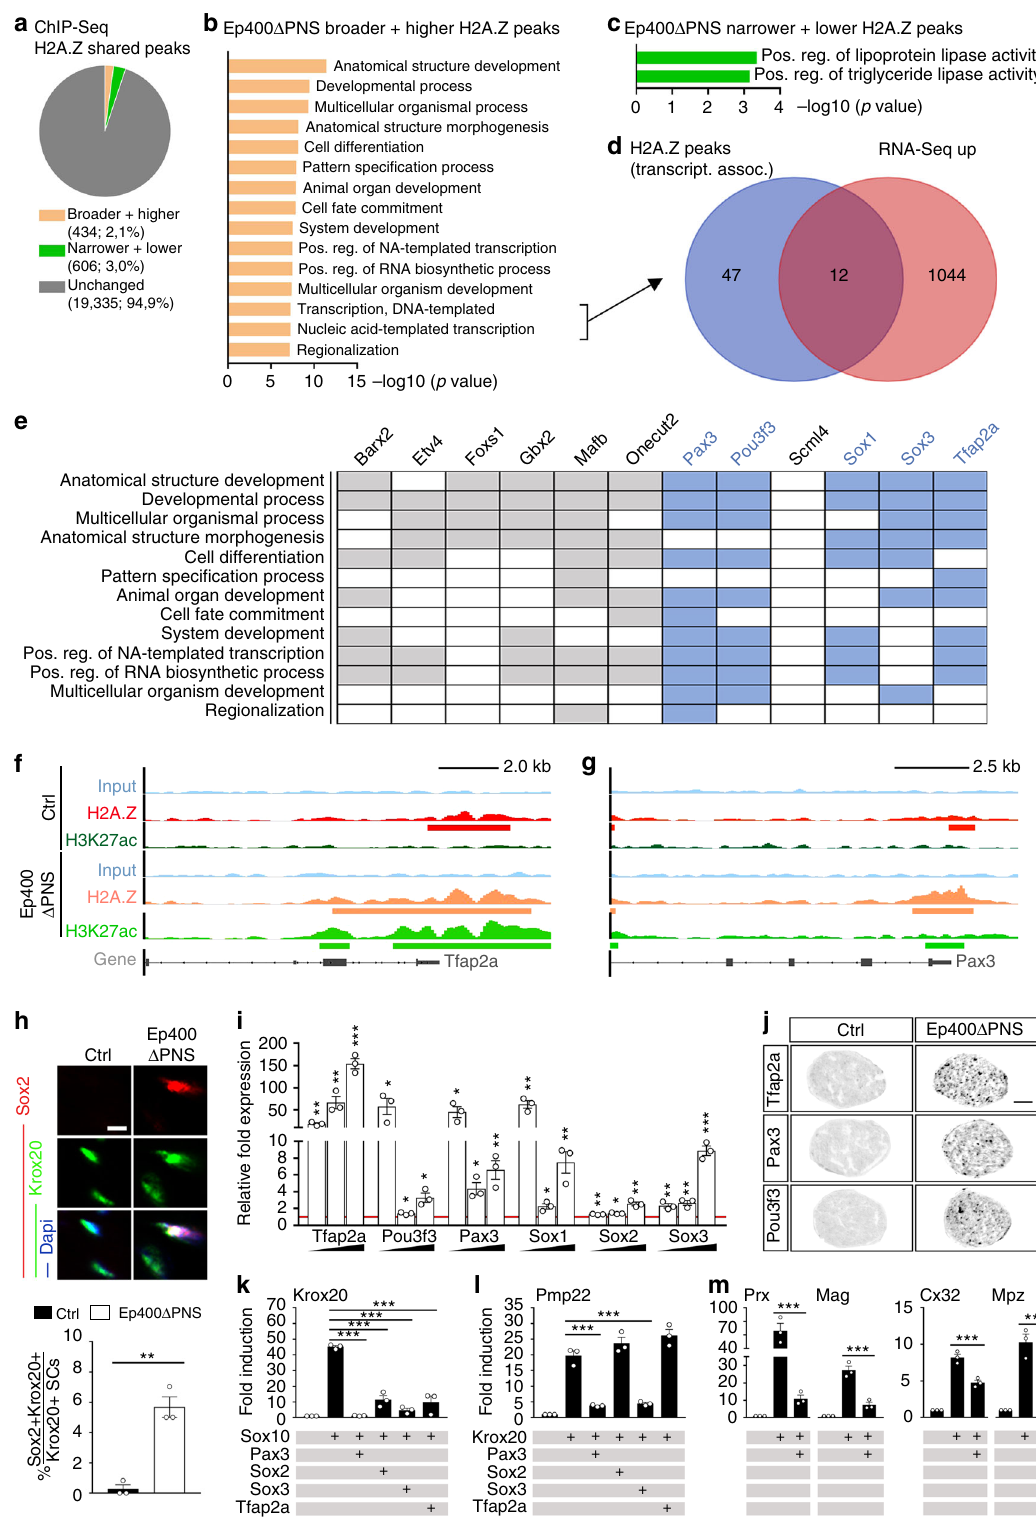
H2A.Z peaks (transcript.